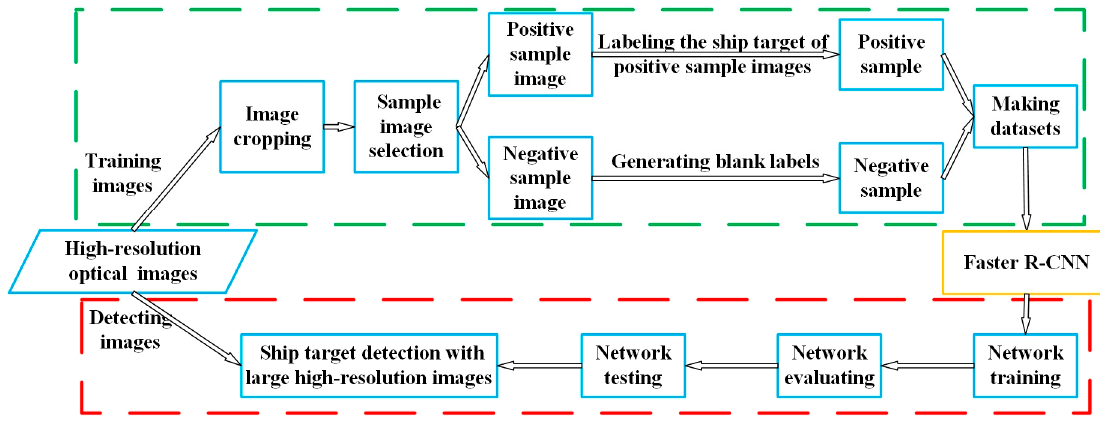
Figure 2. Faster R-CNN-based flow chart of our algorithm.